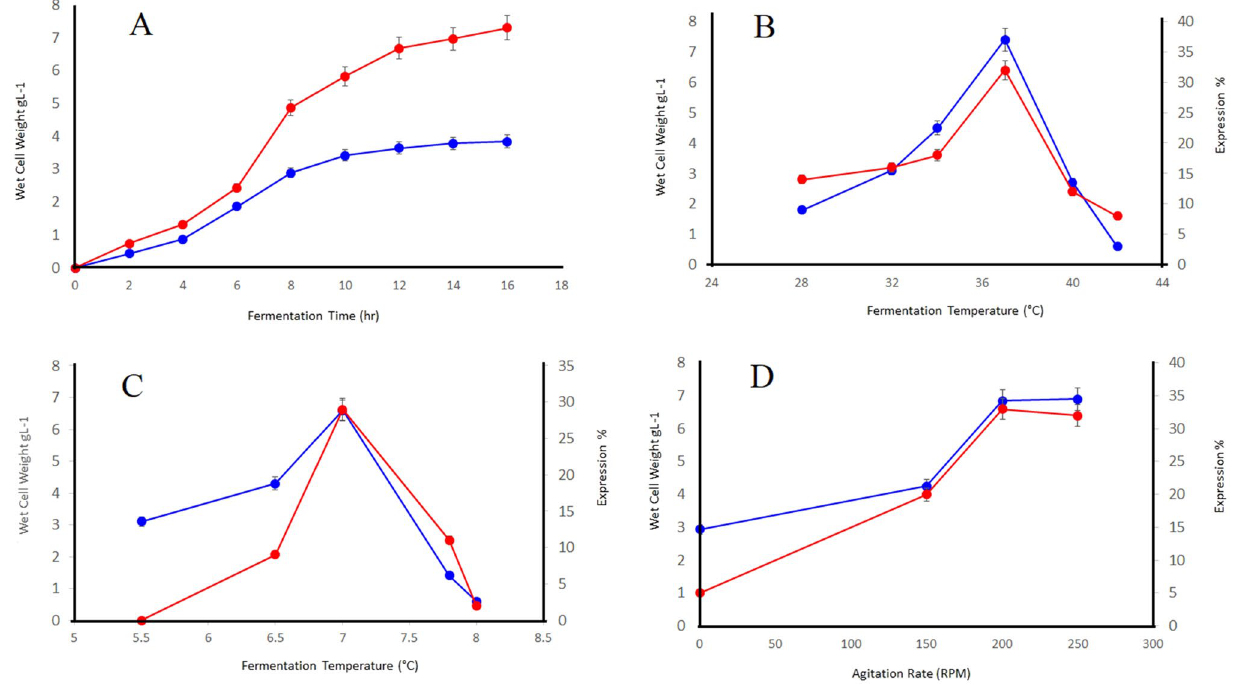
Figure 3. ( A ) Time course of recombinant cellulase fermentation by E. coli BL21 (DE3) in LB ( □ ) and modified M9NG media ( ♦ ) over 16 h of shake flask fermentation. Effect of ( B ) temperature, ( C ) pH and ( D ) agitation rate on recombinant cellulase fermentation by E. coli BL21 (DE3) determined by incubating at different fermentation temperature, pH and agitation rates respectively. Wet cell weight ( ♦ ), recombinant cellulase expression ( □